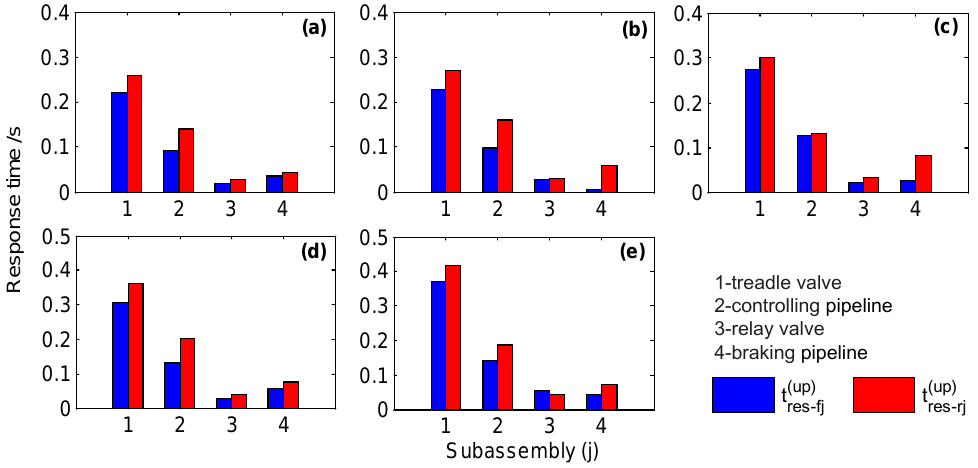
Figure 15. Response time of each subassembly in brake process under the testing condition from group 1 to group 5, shown in ( a )–( e ) respectively.